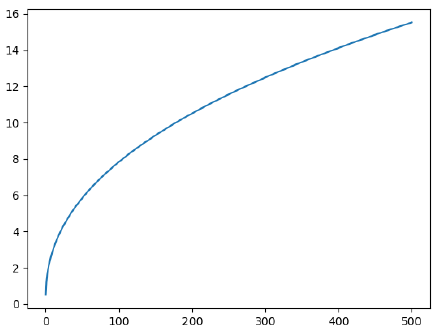
Figure 7. A graph of a L ( t ) with k = 1 and r = 2, which appears to be strictly